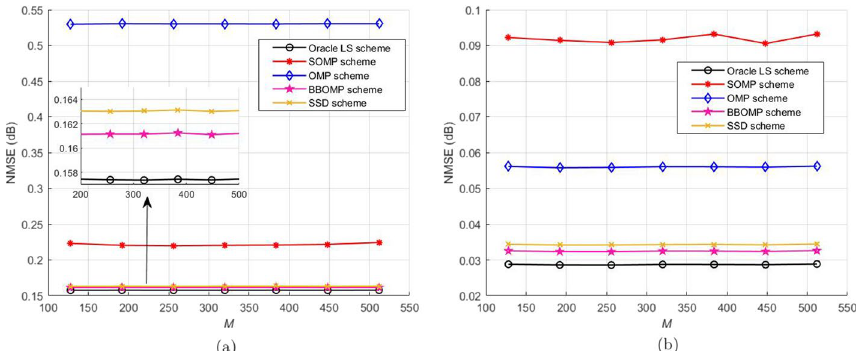
Fig. 8 The NMSE performance of all schemes when the number of sub-carriers changes. a . SNR